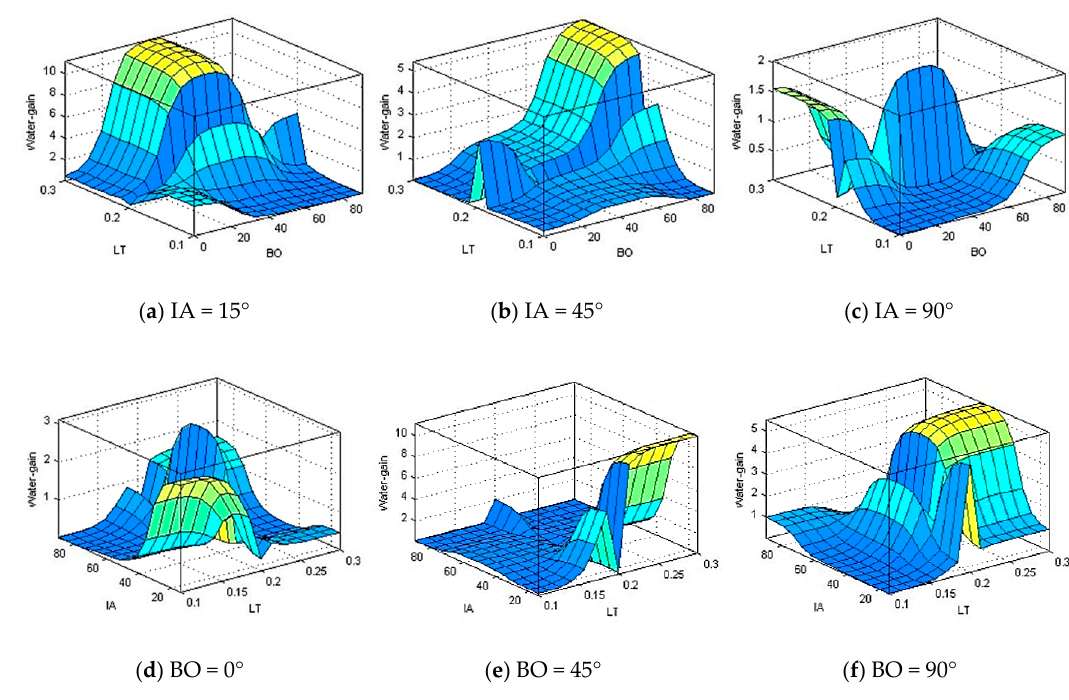
Figure 14. Water gain in relation to change of building orientation (BO), layer thickness (LT), and impact angle (IA) at ( a ) IA = 15°, ( b ) IA = 45°, ( c ) IA = 90°, ( d ) BO = 0°, ( e ) BO = 45°, and ( f ) BO = 90°.